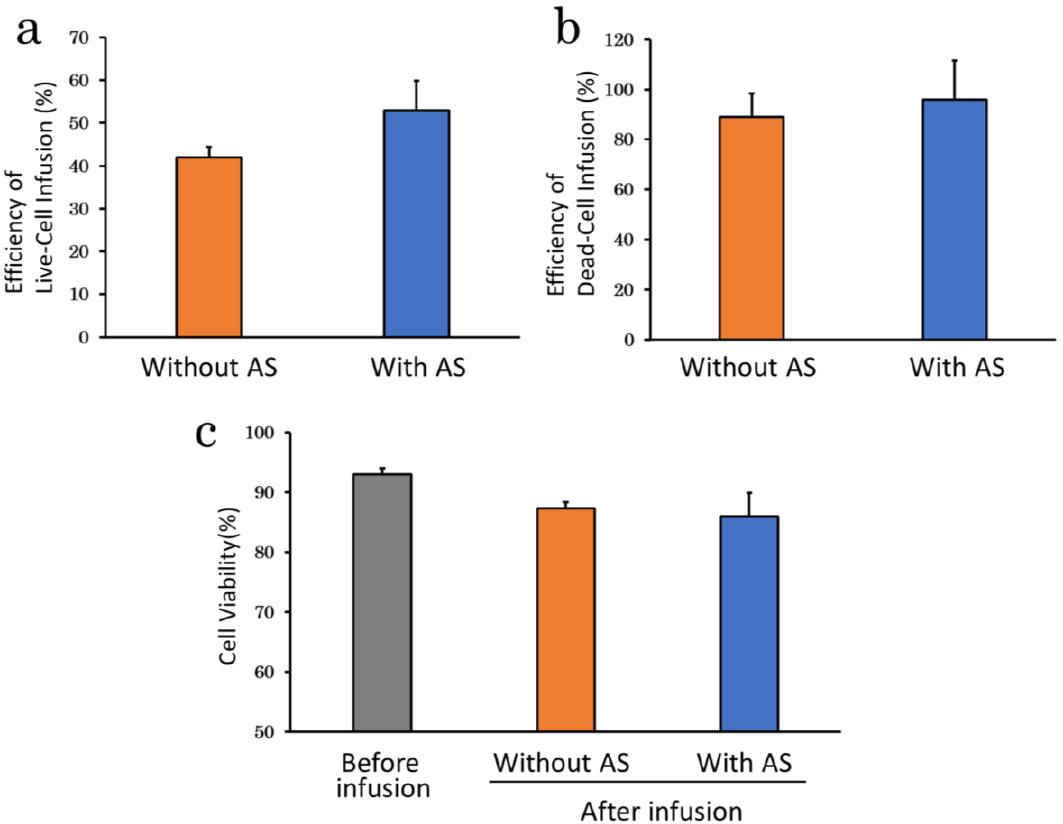
Figure 4. Differences in efficiency of cell infusion and cell viability with and without AS. ( a ), Effi- ciency of live-cell infusion with and without AS. There were no significant differences, but efficiency of live-cell infusion tended to be higher with AS; ( b ), Efficiency of dead-cell infusion with and with- out AS. Efficiency of dead-cell infusion also tended to be higher with AS; ( c ), Cell viability with and without AS. Supplementation of AS slightly decreased in viability. AS: allogenic